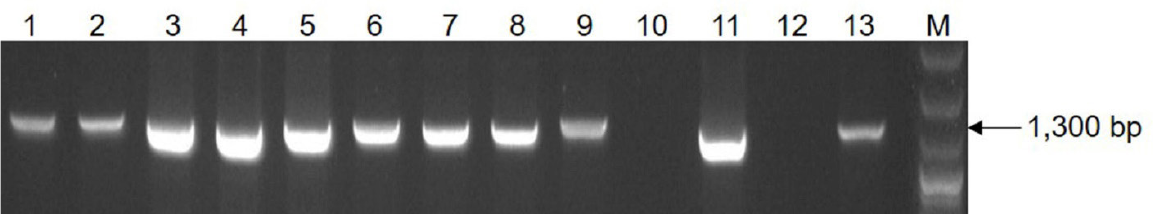
Figure 6: Detection of Begomovirus in diseased pepper leaf samples in this study. The agarose gel shows the amplified products obtained from the begomovirus-specific primers PAL1v1978 and PAR1c496 with an estimated size of 1,300 bp (lane 1-9, 11, and 13). Lane M, 100 bp DNA marker; Lane 10 and 12, negative